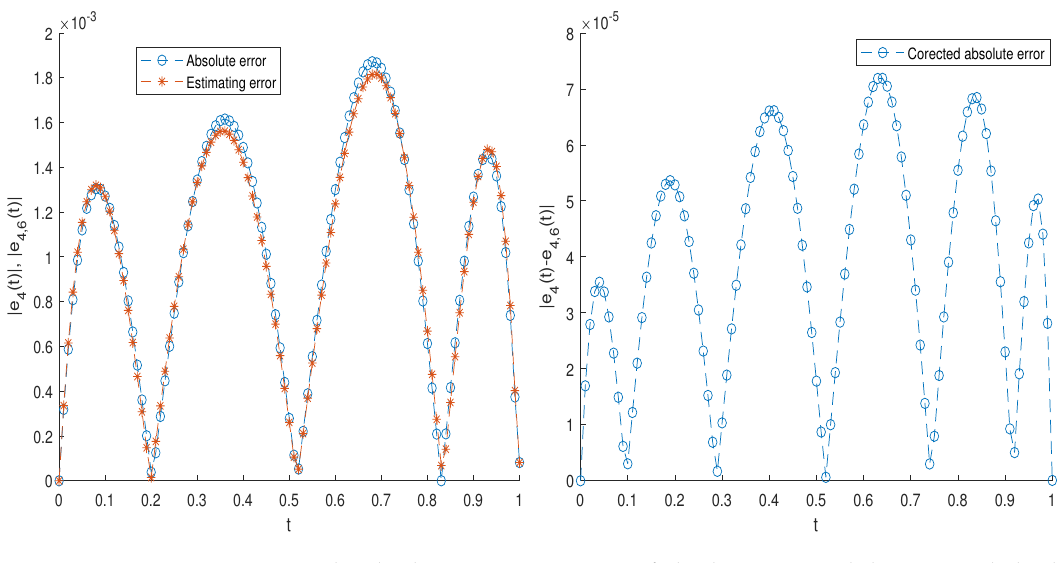
Figure 14. The absolute error, estimation of absolute error and the corrected absolute error for Example 5, for ( N , M ) = ( 4,6 ) with ν = 1.